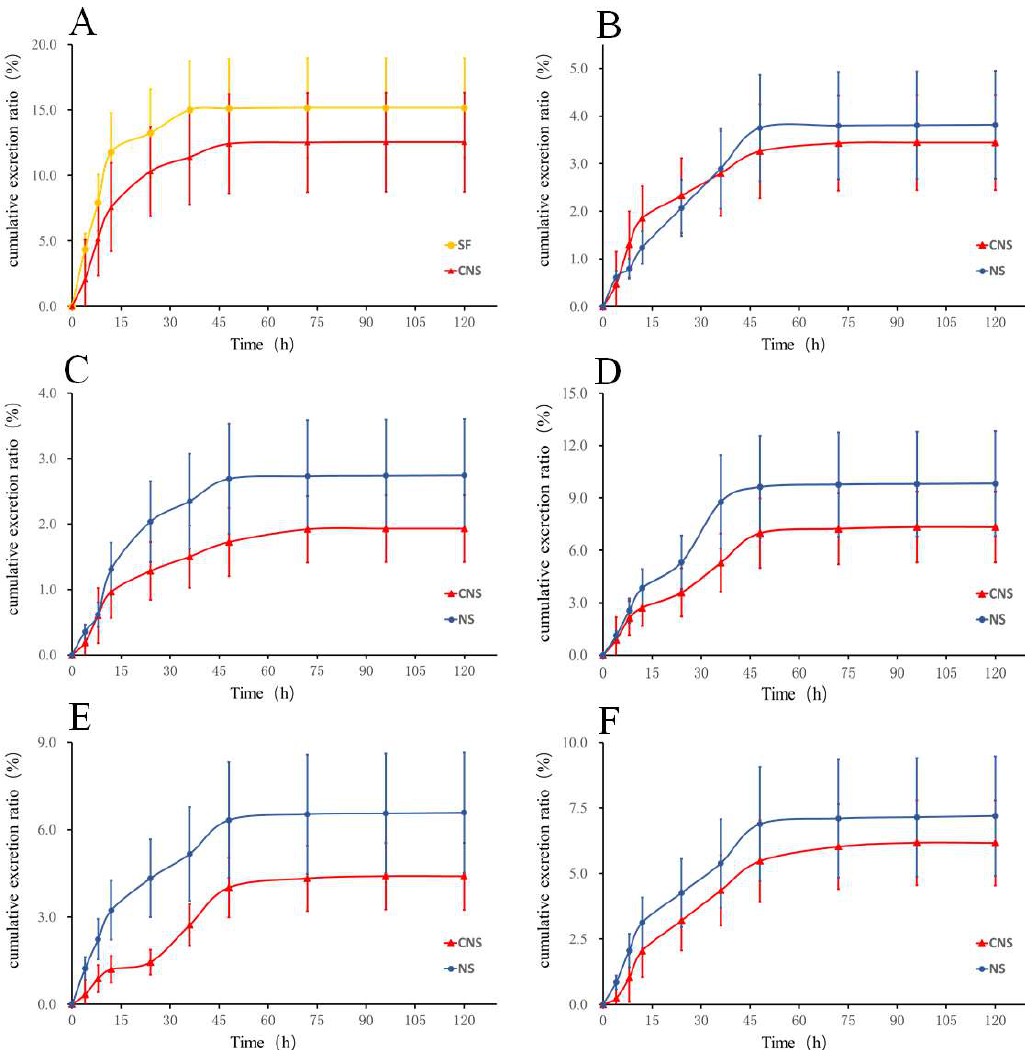
Figure 2. Fecal cumulative excretion profile of ( A ) HSYA in rats after oral administration of SF and CNS and ( B ) Ginsenoside Rg1, ( C ) Ginsenoside R1, ( D ) Ginsenoside Rd, ( E ) Ginsenoside Rb1, and ( F ) Ginsenoside Re in rats after oral administration of NS and CNS ( n = 6).